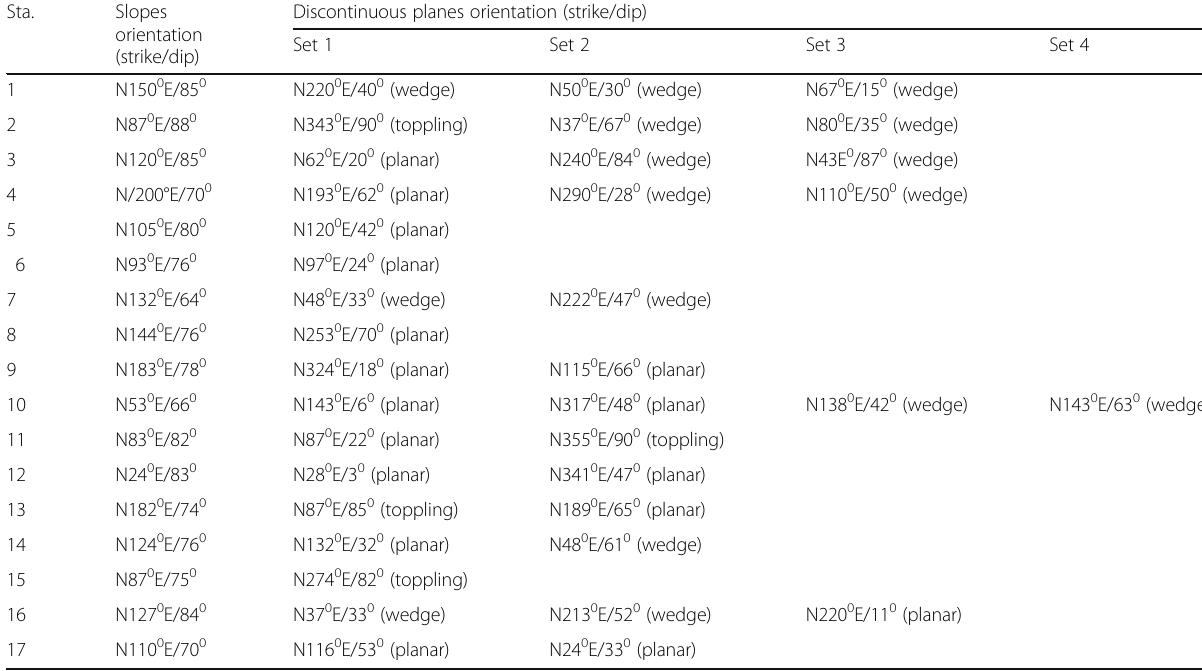
Slope mass rating (SMR) analysis Road segments without slopes were not classified because the assessment of the slope mass quality cannot be con- ducted without the rock slopes as the observed objects. The summary of the classified slopes according to the Slope Mass Rating (SMR) by Romana (1993) is shown in Table 16. Overall, there were none of good quality mass slopes in the study area. The measured SMR score ranged from normal to very bad. The andesite unit represented by 1 (one) station of ob- servation point has SMR value of 51.27 and categorized